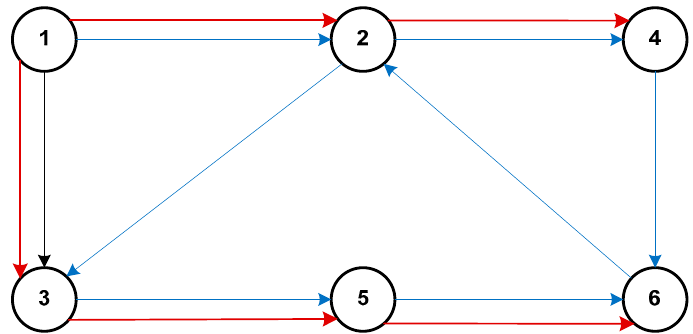
Figure 4. A directed spanning tree of a directed graph with six nodes.